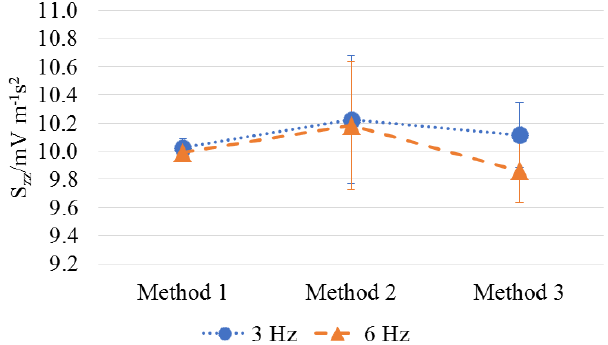
Figure 12. Piezo-electric accelerometer: comparison between methods (main sensitivity along the x axis, S zz ).